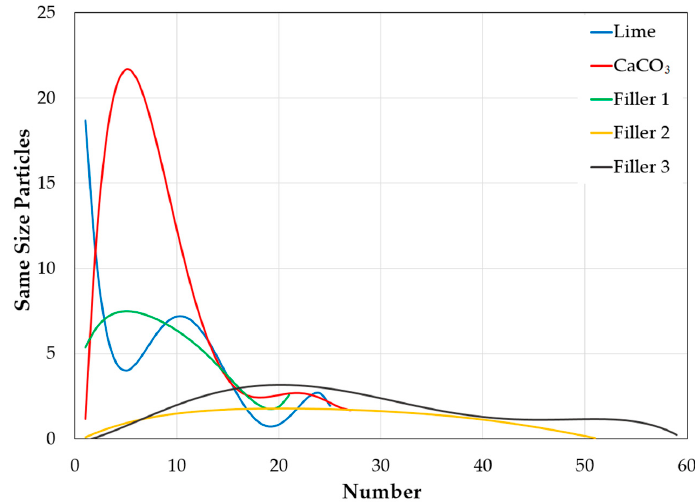
Figure 5. Granulometric composition of lime, CaCO 3 , Filler 1, Filler 2, and Filler 3.